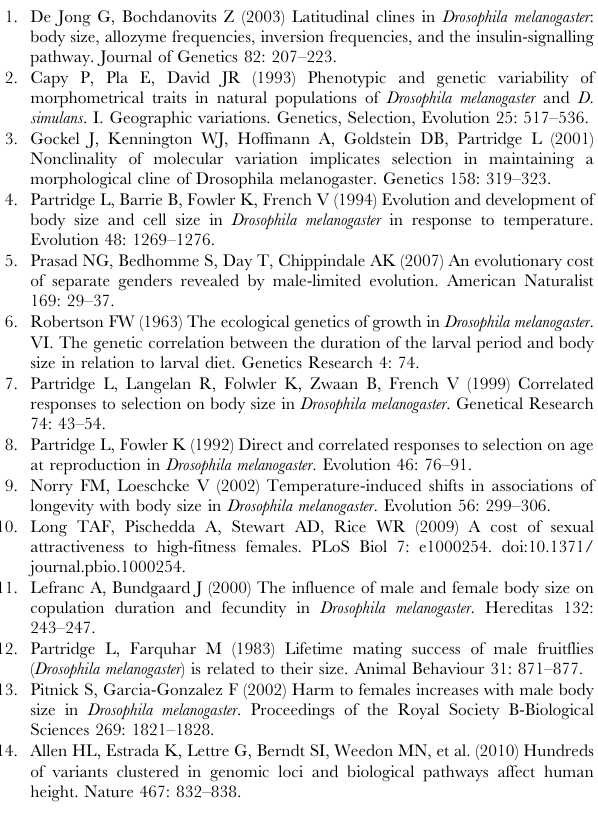
Figure S5 Low bias introduced by estimating starting allele frequency. A: the proportion of variants with average frequency of 0.40–0.60, depending on starting frequency. B: Distribution of expected allele frequency differentiation for alleles which have a final average frequency between 0.45–0.50 in the two control populations; colors indicate starting allele frequencies, red =0.50; orange =0.45, yellow =0.40; green= 0.35; blue =0.30; pur- ple = 0.25; fuchsia= 0.20. The distribution is very similar until starting allele frequency is 0.25 or less, and few alleles with this starting frequency end with an average frequency between 0.40– 0.60, as shown in A. Table S1 Significance of anatomical measurements. Table S2 False discovery rates for each allele frequency class at various thresholds for autosomes. Table S3 False discovery rates for each allele frequency class at various thresholds for the X